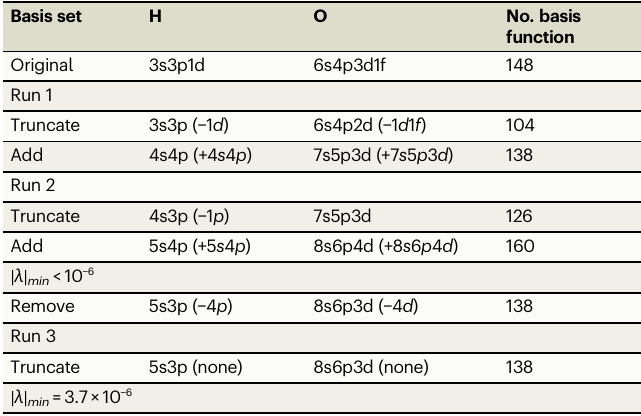
Table 1 | The steps of the CBS scheme for def2-TZVPPD basis set in the H 2 O dimer system Basis